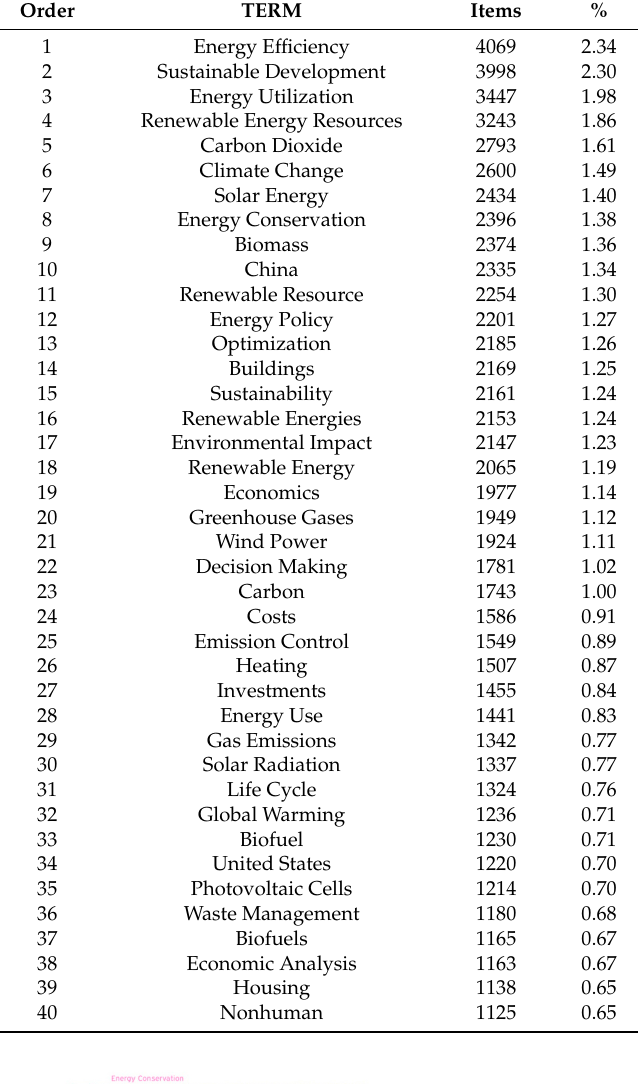
Table 5. List of the 40 most used keywords.